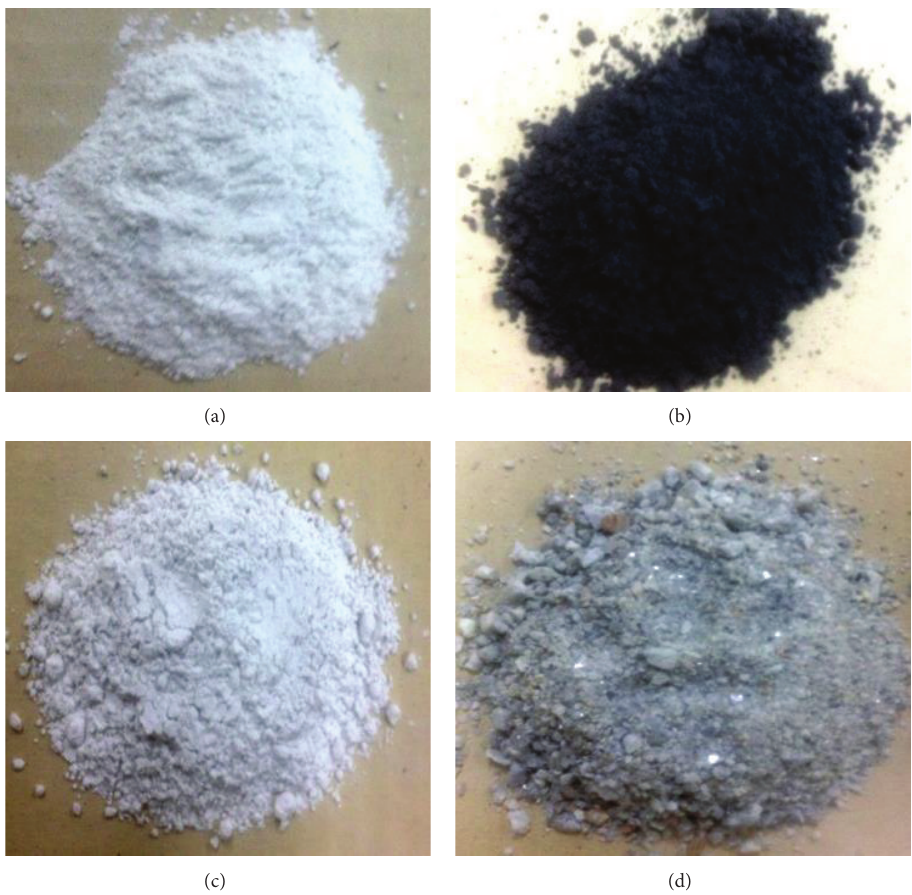
Figure 5: (a) Metakaolin (MK), (b) palm oil fuel ash (POFA), (c) ground granulated blast furnace slag (GGBS), and (d) manufactured sand (M-sand).